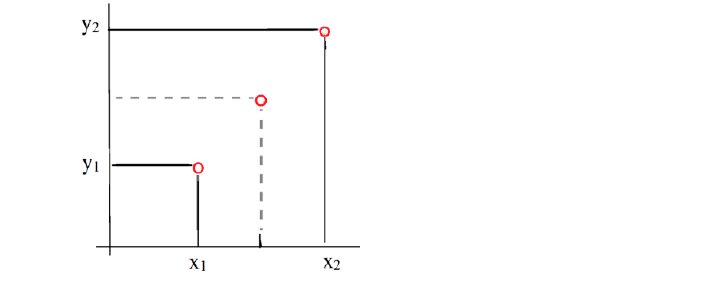
Figure 1. Given two known points (x 1 ,y 1 ) and (x 2 ,y 2 ), the linear interpolant is the straight line between these points.